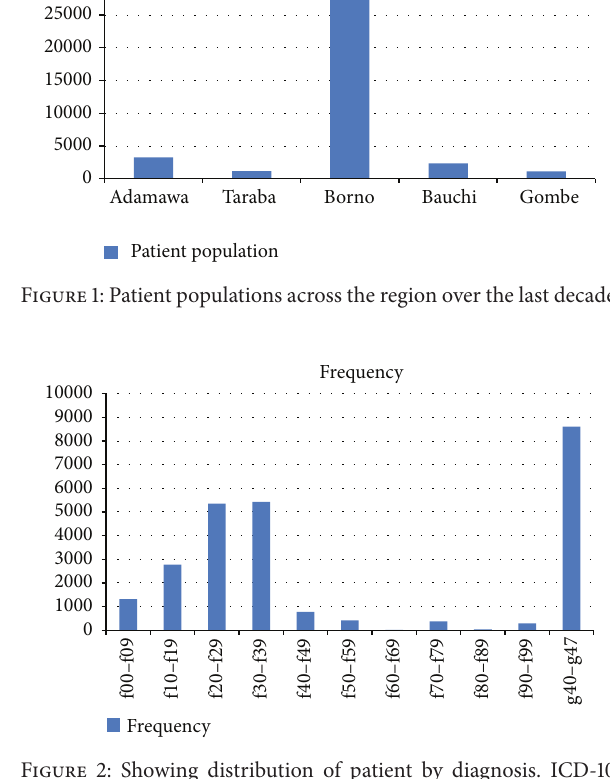
Figure 2: Showing distribution of patient by diagnosis. ICD-10: Classification of Mental Disorders, f00–9: Organic Mental Dis- orders, f10–19: Substance Abuse, f20–29: Schizophrenia Spectrum and Delusional Disorders, f30–39: Mood Disorders, f40–49: Neu- rotic Stress Related and Somatic Disorders, f50–59: